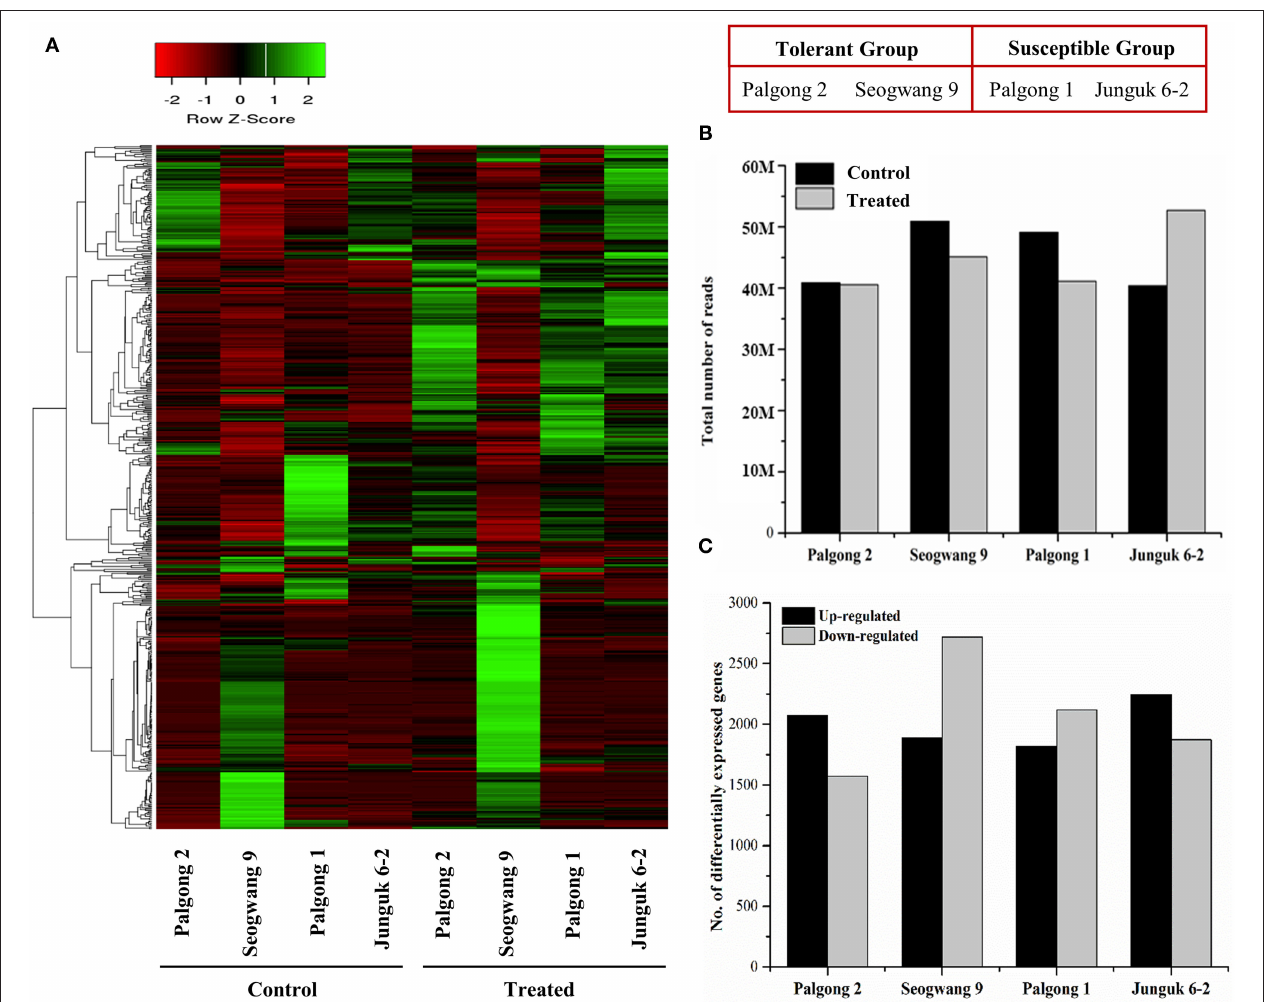
FIGURE 3 | Transcriptome analysis of drought-resistant and susceptible Populus davidiana cultivars following dehydration. Heat map showing the signal intensities of the differentially expressed genes (DEGs) in the control and treated samples of each cultivar after 10min (A) . An average of 45.34 and 44.89 million reads were obtained from the stressed and control samples, respectively (B) . At a Q-value of 0.05, an average of 2,008 upregulated and 2,071 downregulated genes were identified in all the cultivars (C)